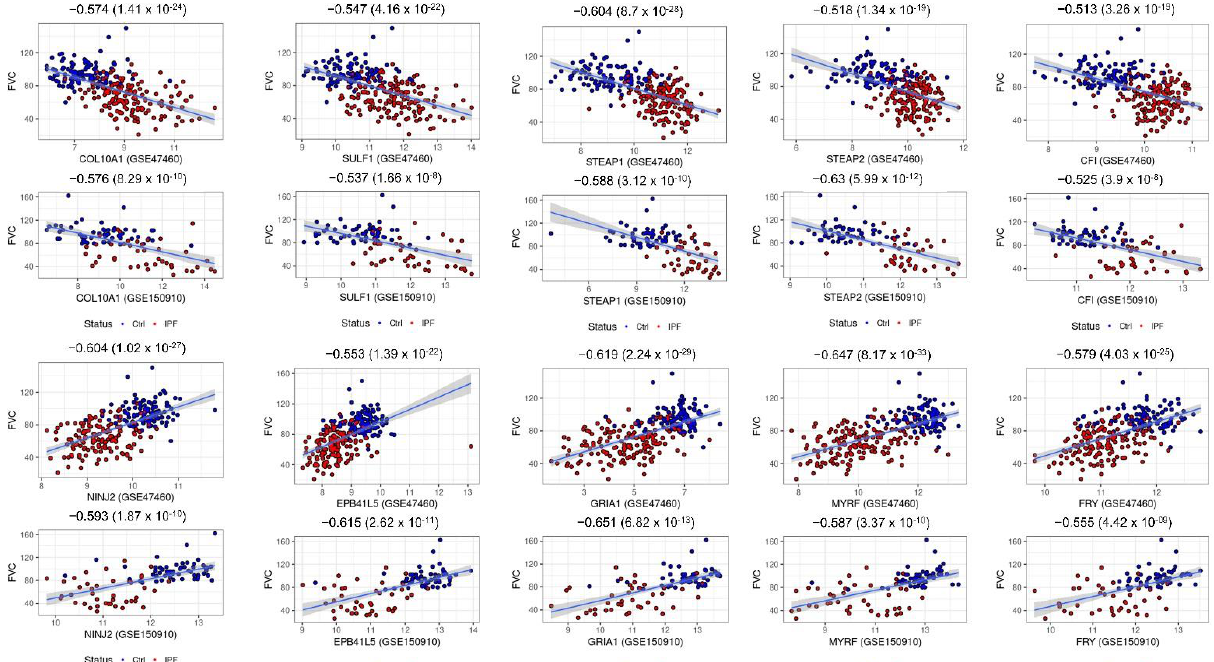
Figure 4. Scatter plots of select candidate hub genes associated with lung function (FVC). Each plot includes sample FVC measures as a function of expression values of intramodular hub genes. All the plots are annotated by the correlation values between the sample FVC measure and the sample expression profile for each gene. Scatter plots for five genes each from the brown ( COL10A1, SULF1, STEAP1, STEAP2, and CFI ) and blue ( NINJ2, EPB41L5, GRIA1, MYRF, and FRY ) modules and their FVC correlations from two independent IPF cohorts are shown. Student ’s asymptotic p -value for given correlations is also included.